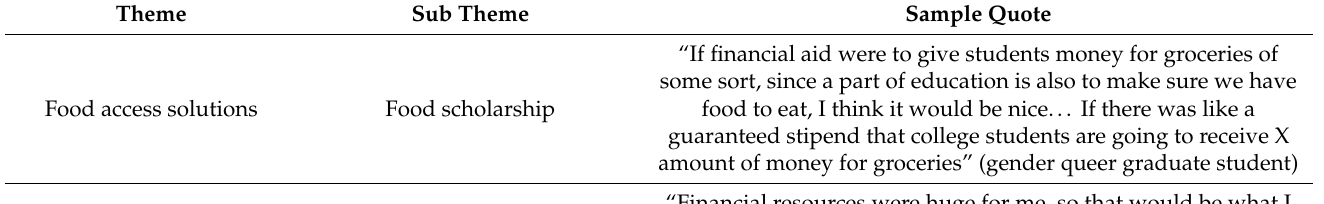
Table 4. Emergent themes and select quotes of students related to proposed solutions to FI and areas of improvement to increase efficacy of food